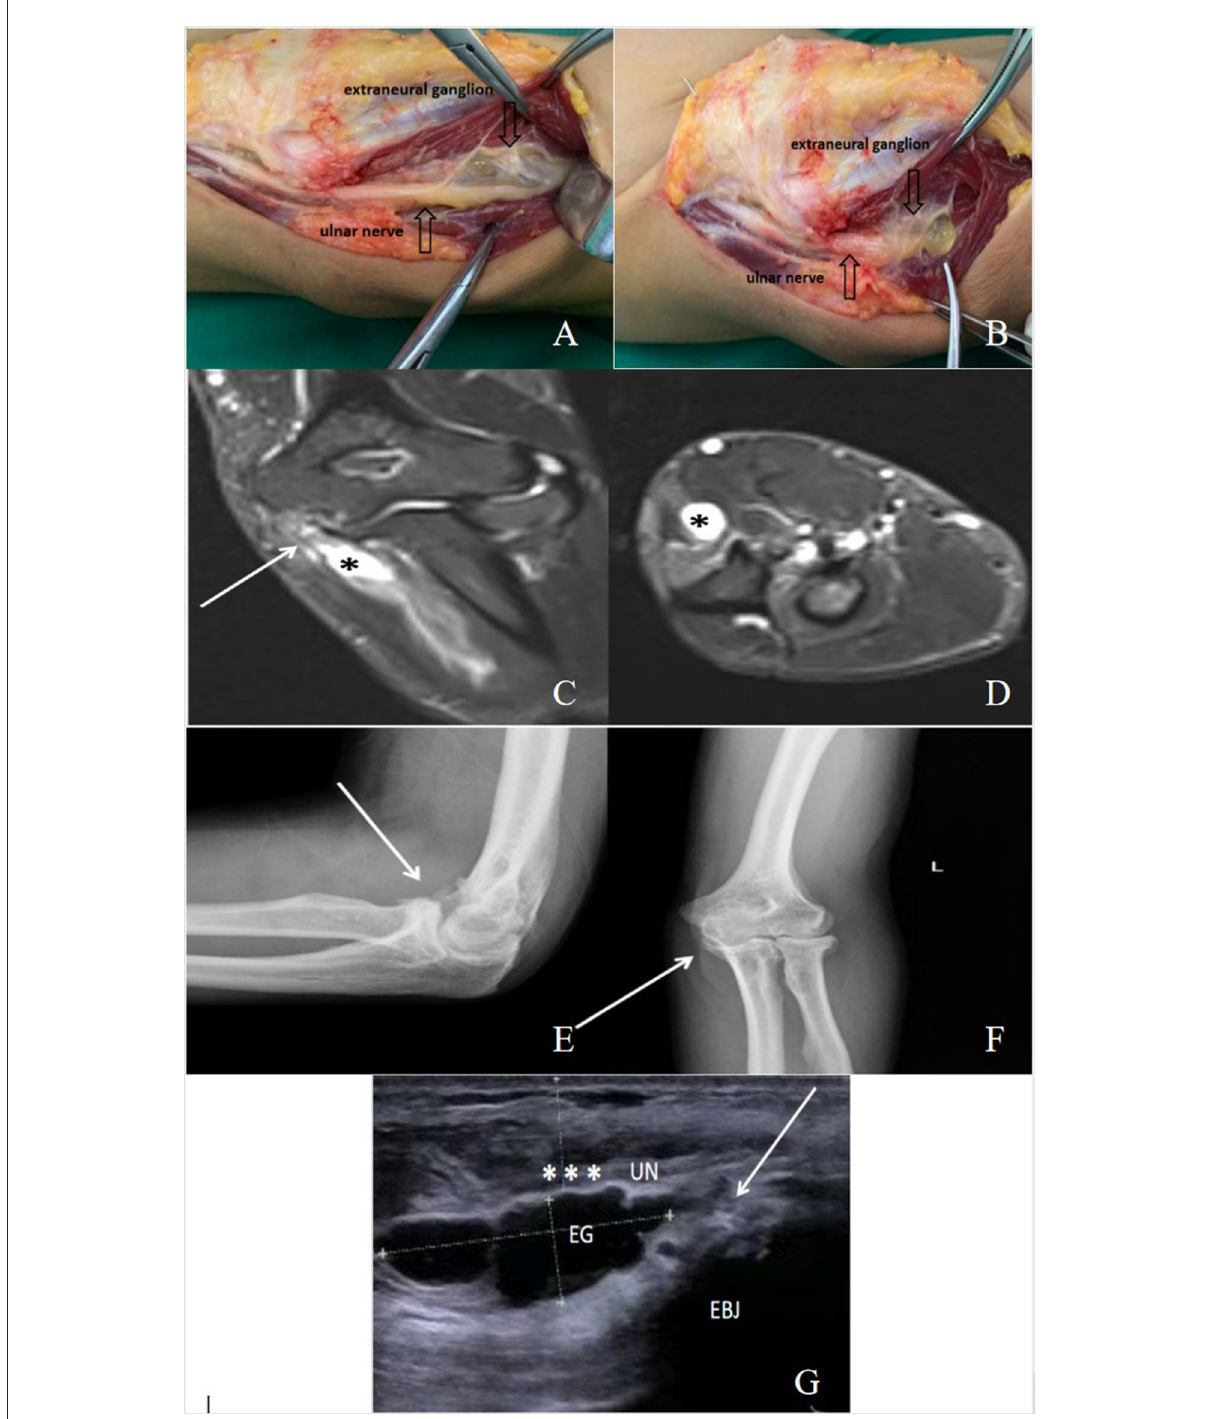
FIGURE2 A 50-year-old male patient with cubital tunnel syndrome caused by extraneural ganglion (EG). (A,B) Intraoperative photograph of the extraneural ganglion, which is compressing and flattening the ulnar nerve in the cubital tunnel. (C,D) The extraneural ganglion ( * ) is shown as (C) , a high signal in T2STIR in sagittal view, and (D) a high signal in T2STIR in transverse view near the elbow joint. (E,F) Anteroposterior and lateral X-ray films of the elbow joint, showing the existence of elbow arthritis (arrow). (G) An ultrasound image showing an extraneural ganglion (EG) compressing the ulnar nerve (UN * ). EBJ: elbow